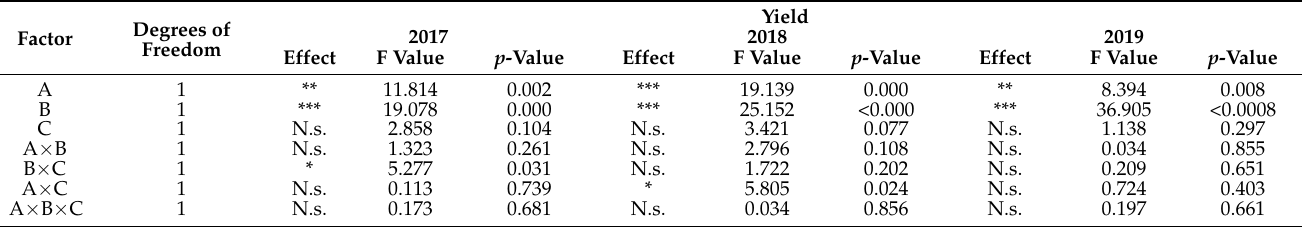
Table 4. Main statistical parameters in trials with two vegetable soybean cultivars grown in two growing technologies and in two plant densities in Latvia, 2017–2019. A: variety, B: growing method (transplanting vs. direct sowing), and C: planting